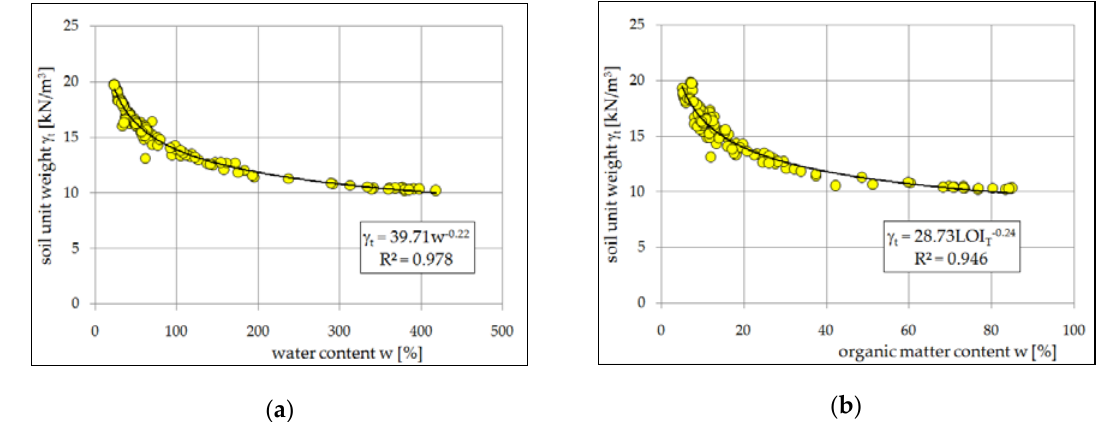
Figure 9. The value of the soil unit weight estimated from laboratory tests was in reference to ( a ) natural water content and ( b ) organic matter content.